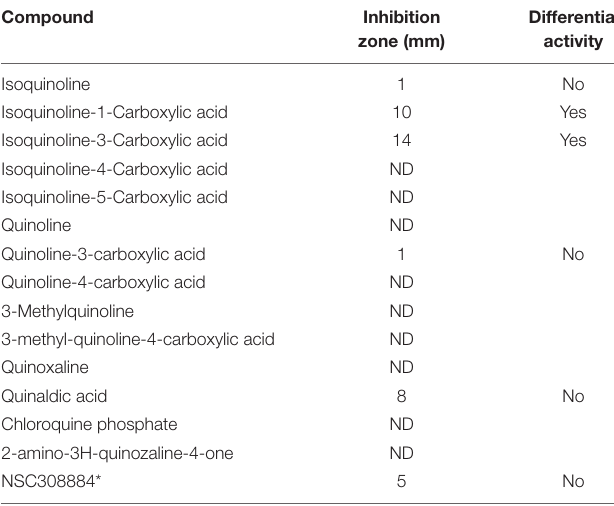
TABLE 1 | Testing various compounds for differential antibiotic activity on the (cid:49) 4 and WT strains. Compound Inhibition